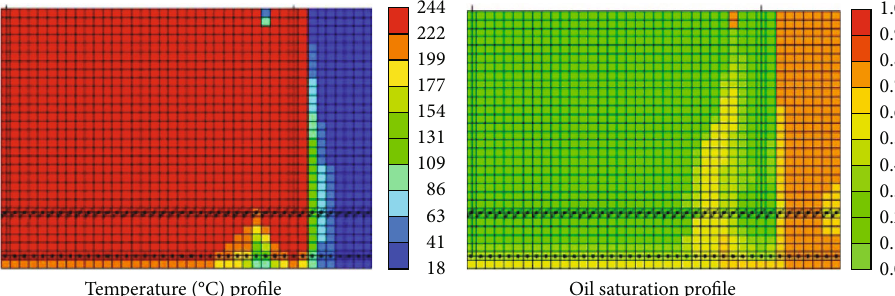
Figure 12: Temperature pro fi les and oil saturation pro fi les of the di ff erent schemes for model